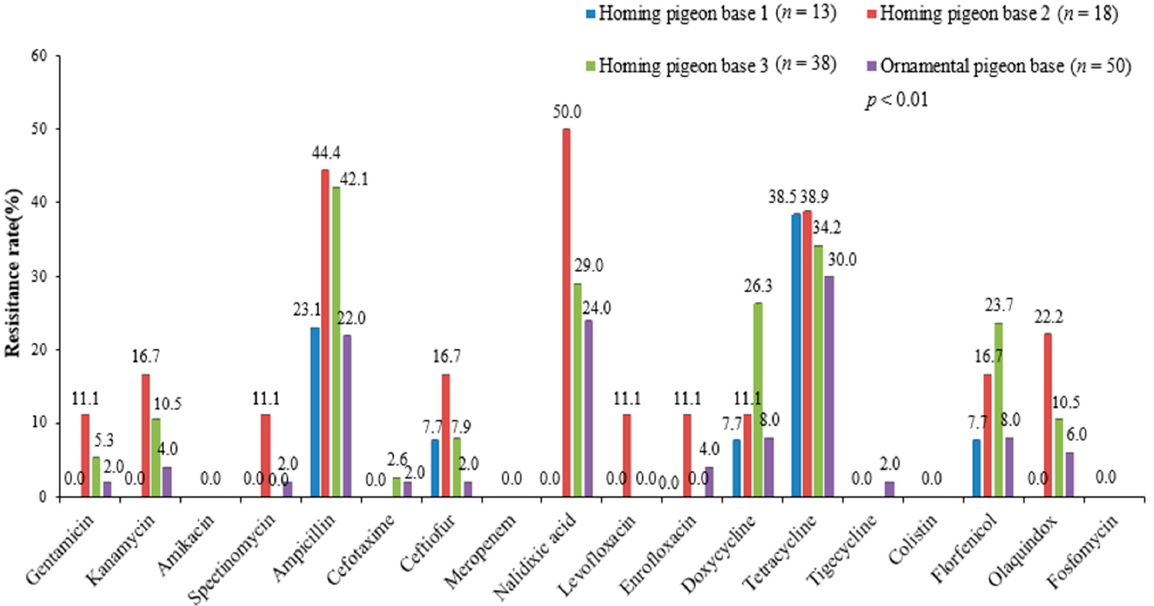
Figure 2. AMR comparison of E. coli isolates from homing and ornamental pigeons in different breeding bases.